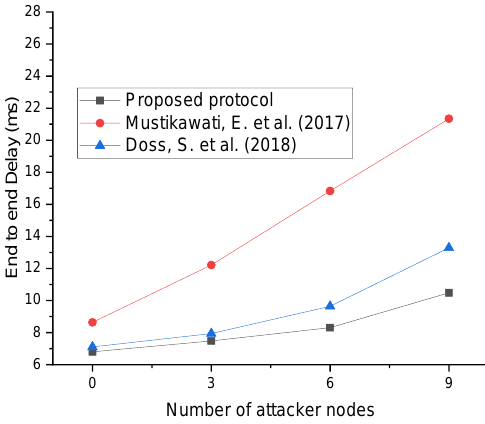
Figure 11. End-to-end delay under Jellyfish periodic drop attacks